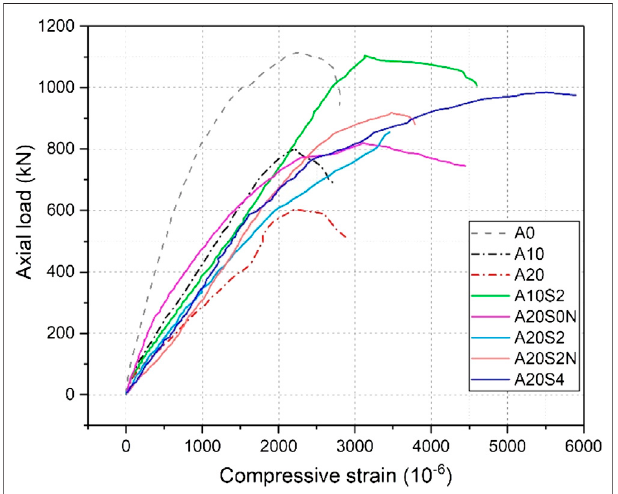
FIGURE 11 | Compressive strain of main reinforcements.